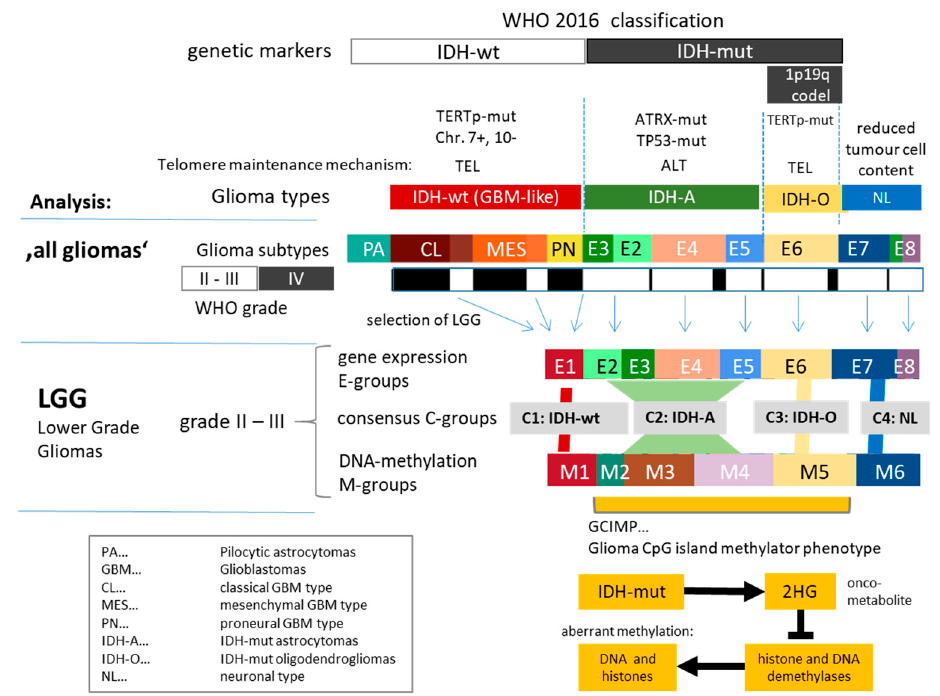
Figure 1. Overview about glioma strata and of their analyses: ‘All glioma’ analysis comprises expression data of pilocytic astrocytomas and of grade II–IV gliomas (LGG and GBM), which were stratified as shown in the figure. Then, combined analysis of expression and DNA methylation data of LGG was performed in order to study the effect of DNA methylation on glioma biology. About 85% of LGG carry mutations in the IDH gene, which causes aberrant methylation of DNA and histone side chains via repression of demethylating enzymes by the onco-metabolite 2 hydroxy-glutamate (2HG). E-groups and M-groups of LGG were stratified strictly on the basis of gene expression and DNA methylation data, respectively (see [20]), which, in consequence, gives rise to only partly matched E- and M-groups as well as genetic WHO-classes based on IDH mutation and chromosome 1p and 19q co-deletion status. Abbreviations and color coding of the groups are used throughout the